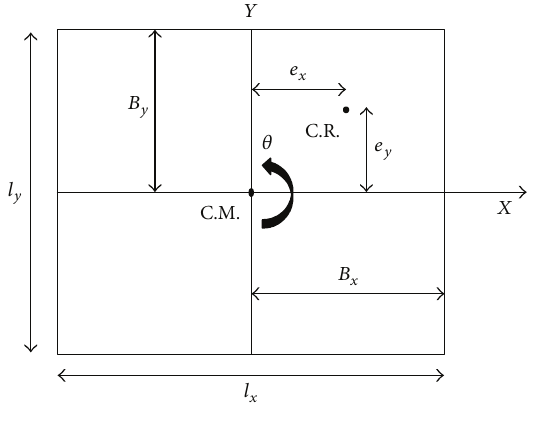
Figure 2: The torsion coupled force.